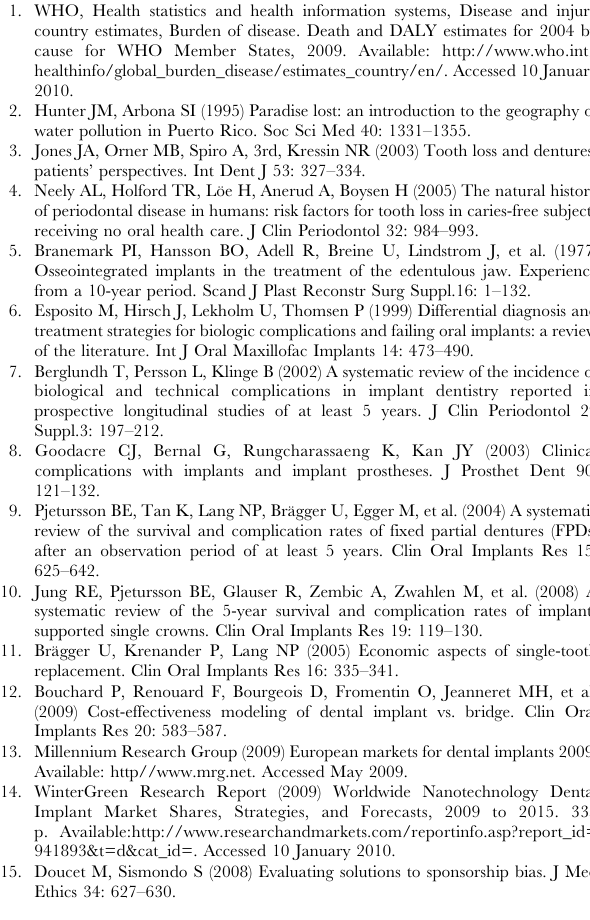
Table S2 List of excluded systematic review articles and the reason for exclusion.